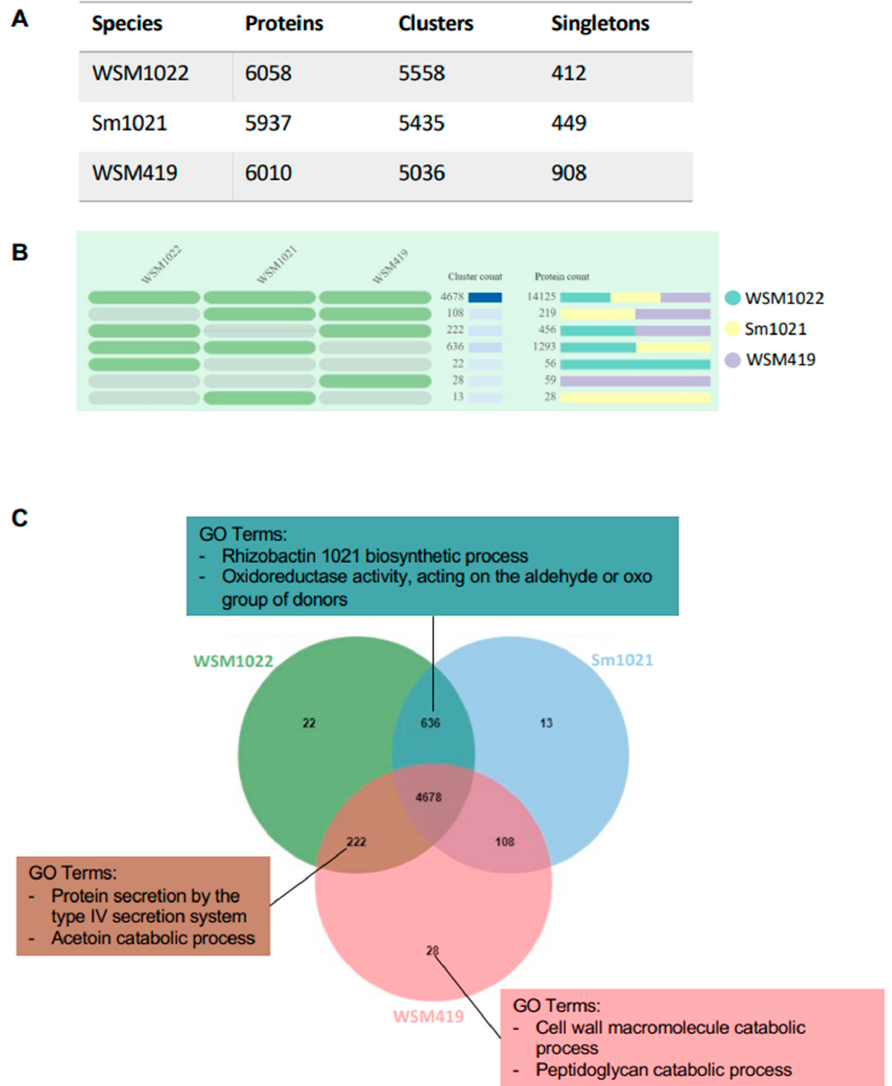
Figure 4. Orthovenn results on orthologous protein clusters in WSM1022, Sm1021 and WSM419. ( A ) Table indicating total number of proteins, number of clusters (highly similar protein sequences) and singletons (cannot be clustered) in each rhizobial species used in this study. ( B ) Presence of cluster groups in each rhizobial species, (dark green—presence, light green—absence). Cluster count represents the number of protein clusters within each cluster group (darker blue for higher protein cluster counts). Protein counts reflect the number of proteins within each protein cluster, colours refer to the distribution of those protein counts in each species. ( C ) Venn diagram showing the number of protein clusters identified in each species). Interesting GO Terms that were found enriched in certain cluster groups are also added and affixed to the associated region.